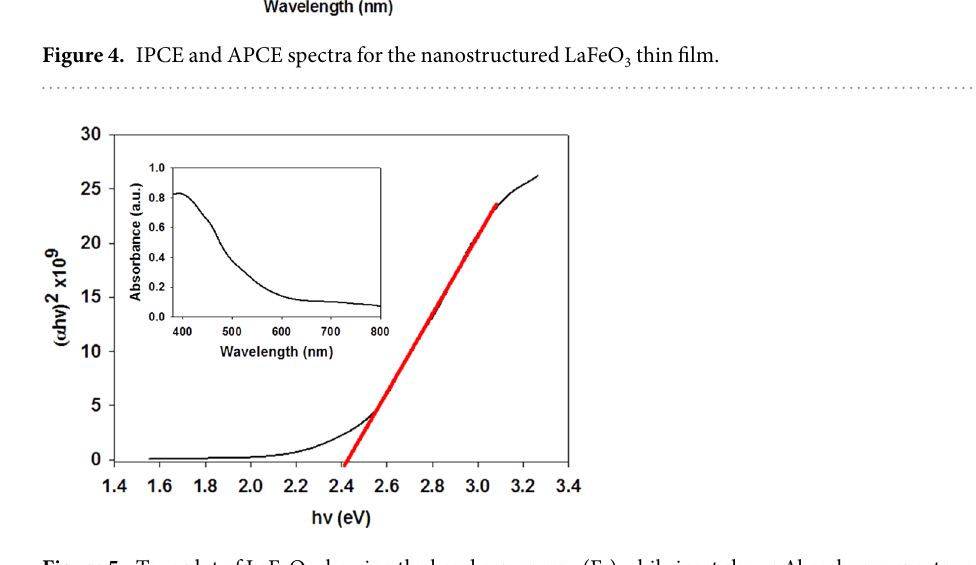
Figure 5. Tauc plot of LaFeO 3 showing the band gap energy (E g ) while inset shows Absorbance spectra of LaFeO 3